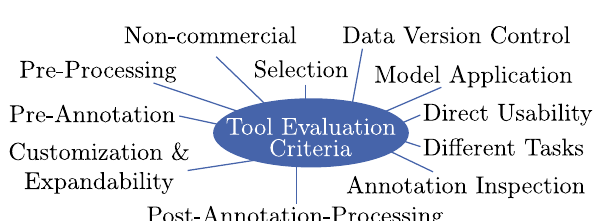
Figure 3: Criteria usability study. The authors of Grid Screener [29] enumerate accessibility, expandability, software/hardware requirements, an available GUI, and user manual as criteria for the evaluation of a software tool in terms of usability.